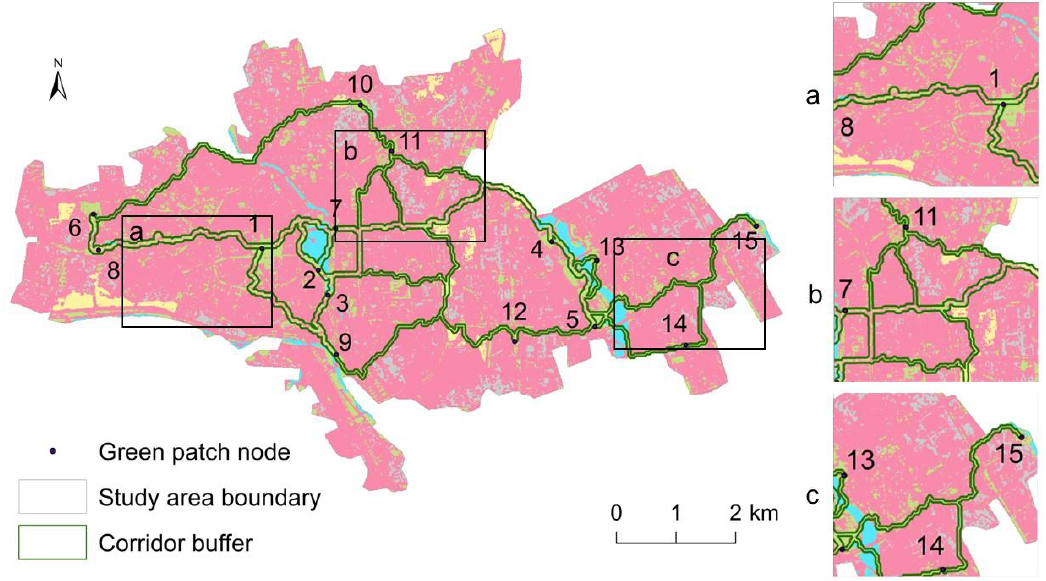
Figure 9. Changes in land use in buffer zones at different distance from potential corridors.